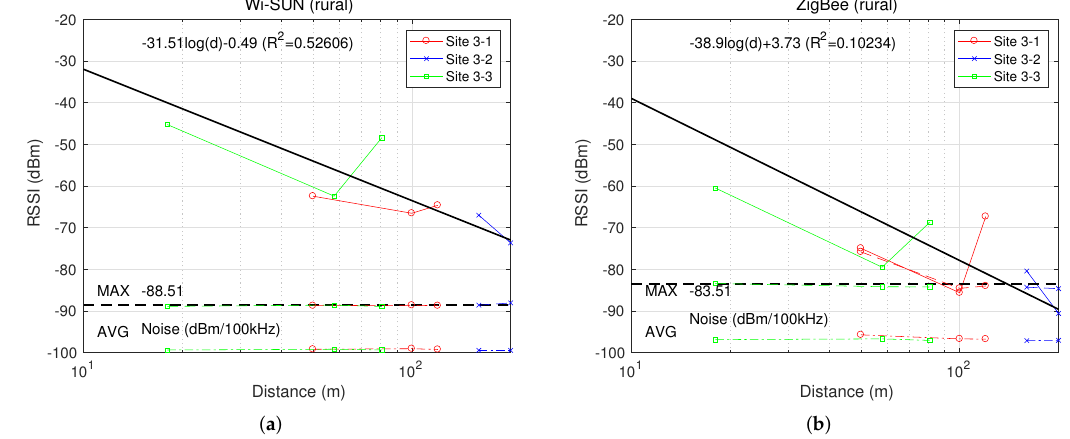
Figure 27. RSSI values for the Overhead Rural Area. ( a ) Wi-SUN. ( b ) ZigBee.